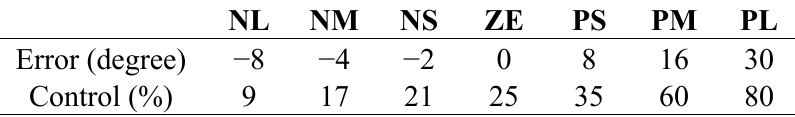
Table 5. Heading Rule